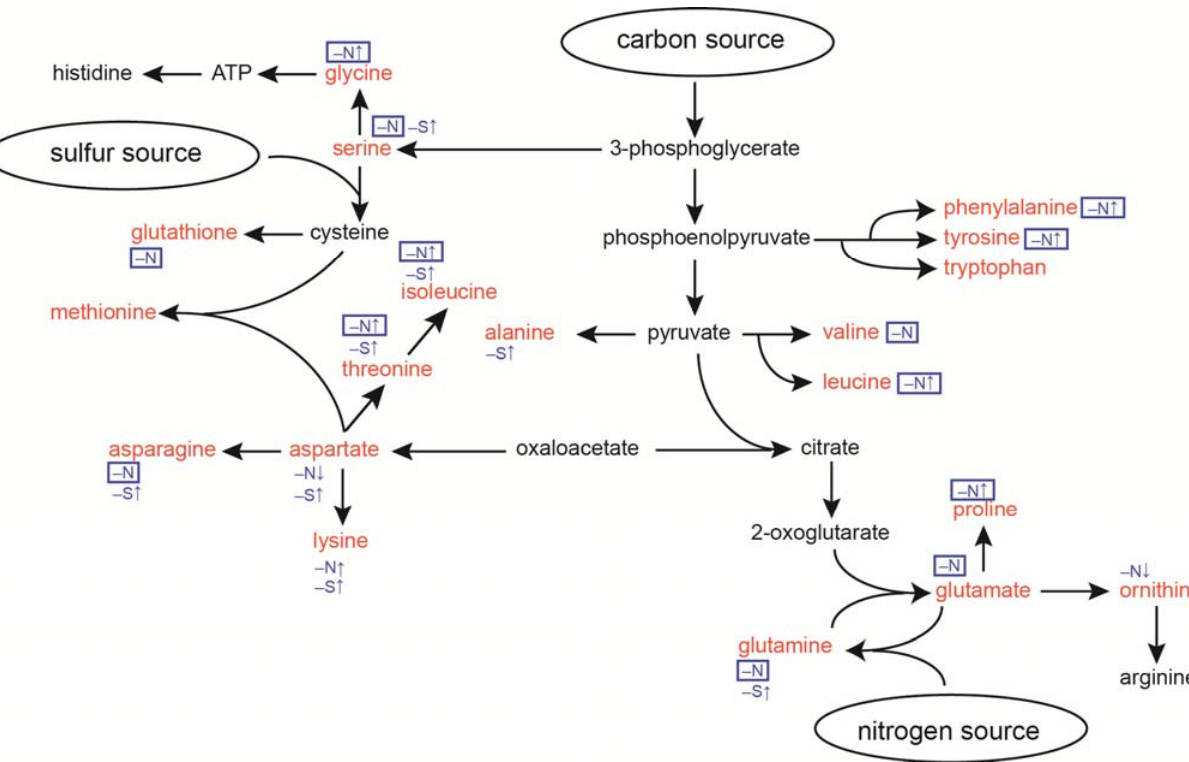
Figure 1. Amino acid biosynthesis pathways in Synechocystis and summary of responses during nitrogen or sulfur starvation. Amino acids shown in red were analyzed in this